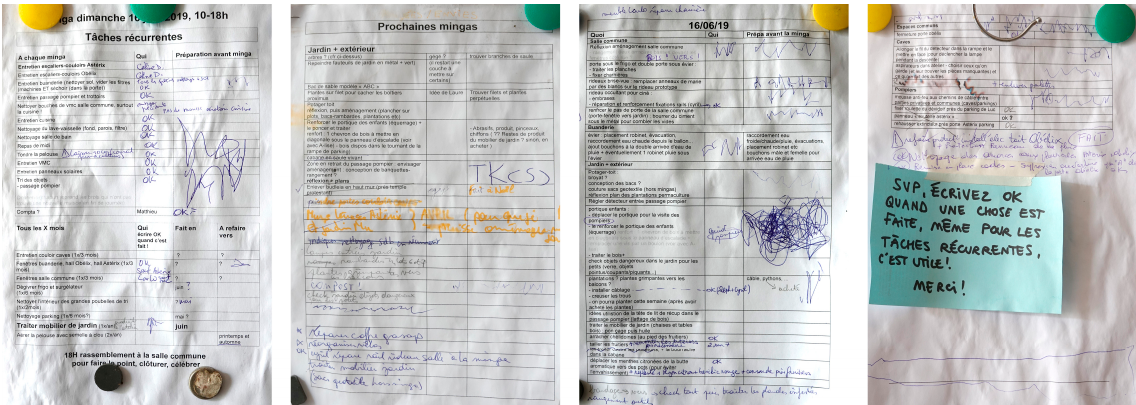
Figure 13. Making invisible work visible, collective chores (photo by the authors, 2019).